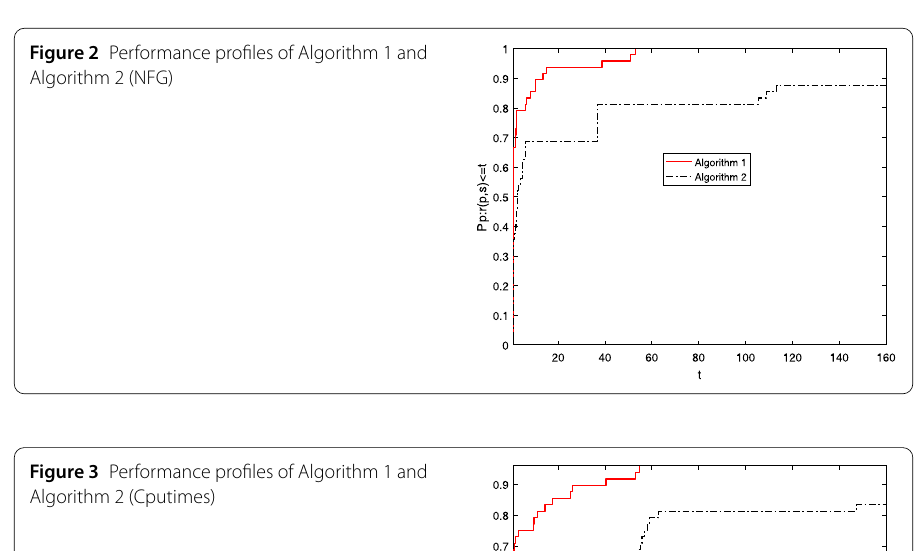
Figure 3 Performance profiles of Algorithm 1 and Algorithm 2 (Cputimes)